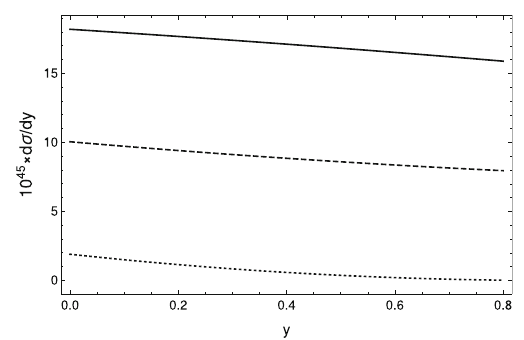
Fig. 8 Dirac (or Majorana) ν e with V – A interaction ˆ η ν · ˆ q = − 1, E ν = 1 MeV : plot of d σ/ dy as a function of y for different values of θ 1 : solid line for θ 1 = 0; dashed line for θ 1 = π/ 2; dotted line for θ = π 1